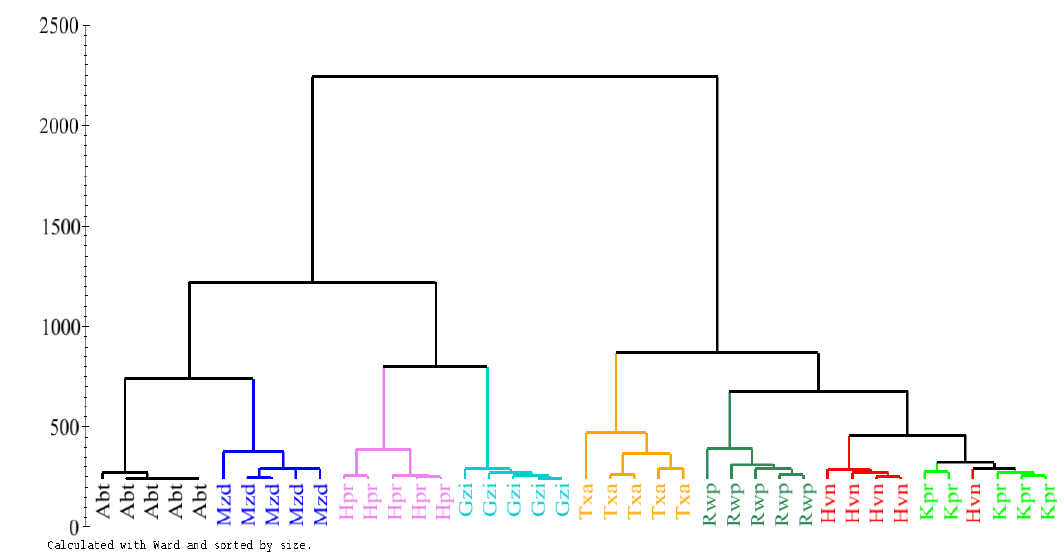
Figure 2. Dendrogram constructed on 1 H-NMR of samples of eight regions (five replications each) of Adhatoda vasica leaves from various regions, i.e., Abbottabad (Abt) at altitude of 4005.91 ft, Muzaffarabad (Mzd) at altitude of 2444.23 ft, Haripur (Hpr) at altitude of 1578.08 ft, Gazi (Gzi) at altitude of 1236.88 ft, Taxila (Txa) at altitude of 1784.78 ft, Rawalpindi (Rwp) at altitude of 1558.40 ft, Havelian (Hvn) at altitude of 2808.4 ft and Khanpur (Kpr) at altitude of 1975.07 ft.